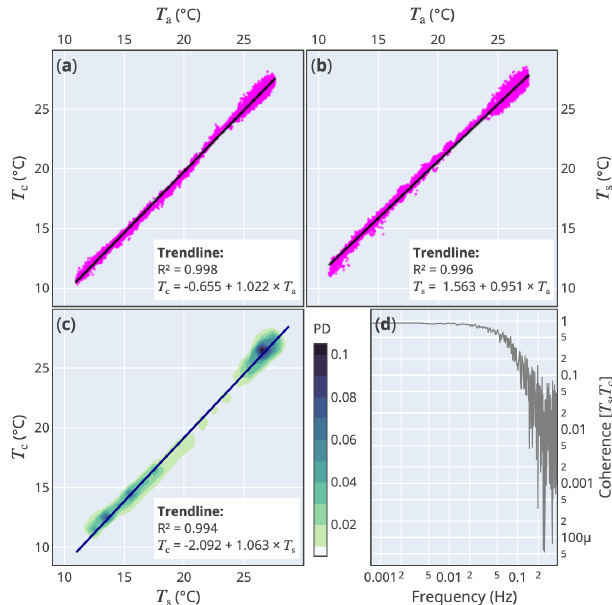
Figure A7. Shown are the correlation between (a) T a and T s , (b) T a and T c , and (c) T s and T c as colour contours representing probability density (PD), as well as (d) the coherence between T s and T c against frequency.